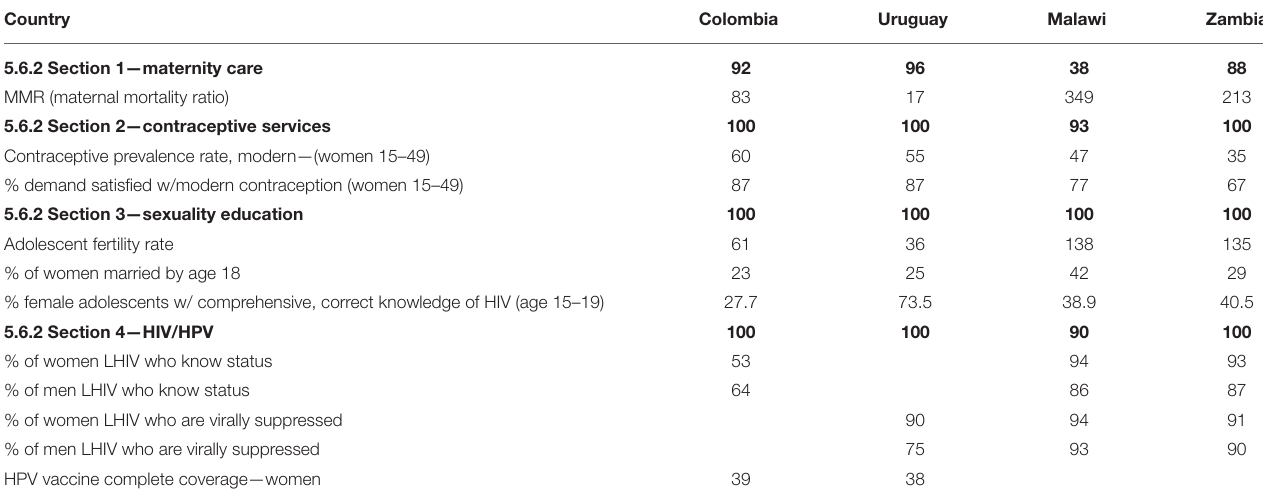
TABLE 3 | Indicator 5.6.2 scores and select SRH outcomes for each country.